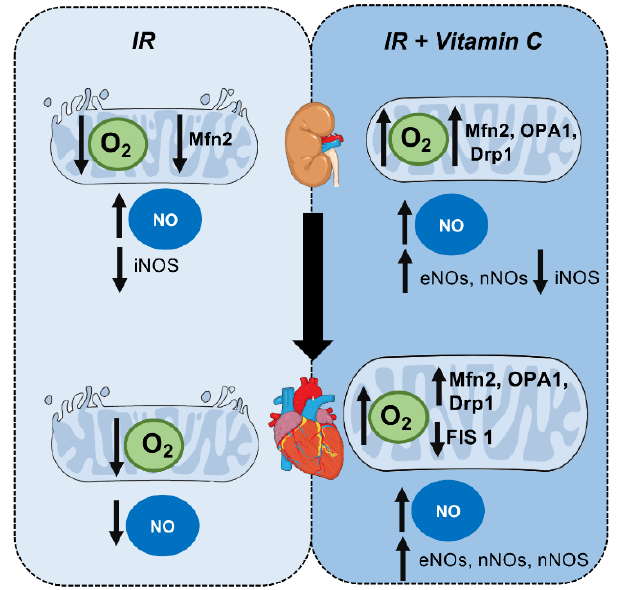
Figure 6. Crosstalk between the kidneys and heart after IR protocol after vitamin C Figure 6 . Crosstalk between the kidneys and heart after IR protocol after vitamin C treatment: mitochondrial behavior. Left side: effect of ischemia/reperfusion on mitochondrial function and nitric oxide levels. It is possible to observe a de- crease in O 2 production followed by an increase in nitric oxide levels in the kidney and a decrease in NO levels in the